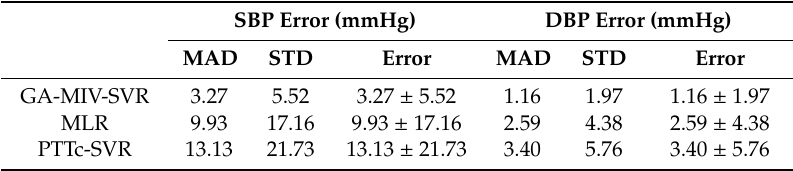
Figure 8. Comparison of predicted values and actual values. ( a ) SBP models. ( b ) DBP models. For both (a) and (b), from top to bottom, using GA-MIV-SVR, traditional multivariate linear regression (MLR), and pulse transit time to point c (PTTc)-SVR models. Table 5. Performance comparison of the models. Abbreviations: mean absolute deviation (MAD); standard deviation (STD).